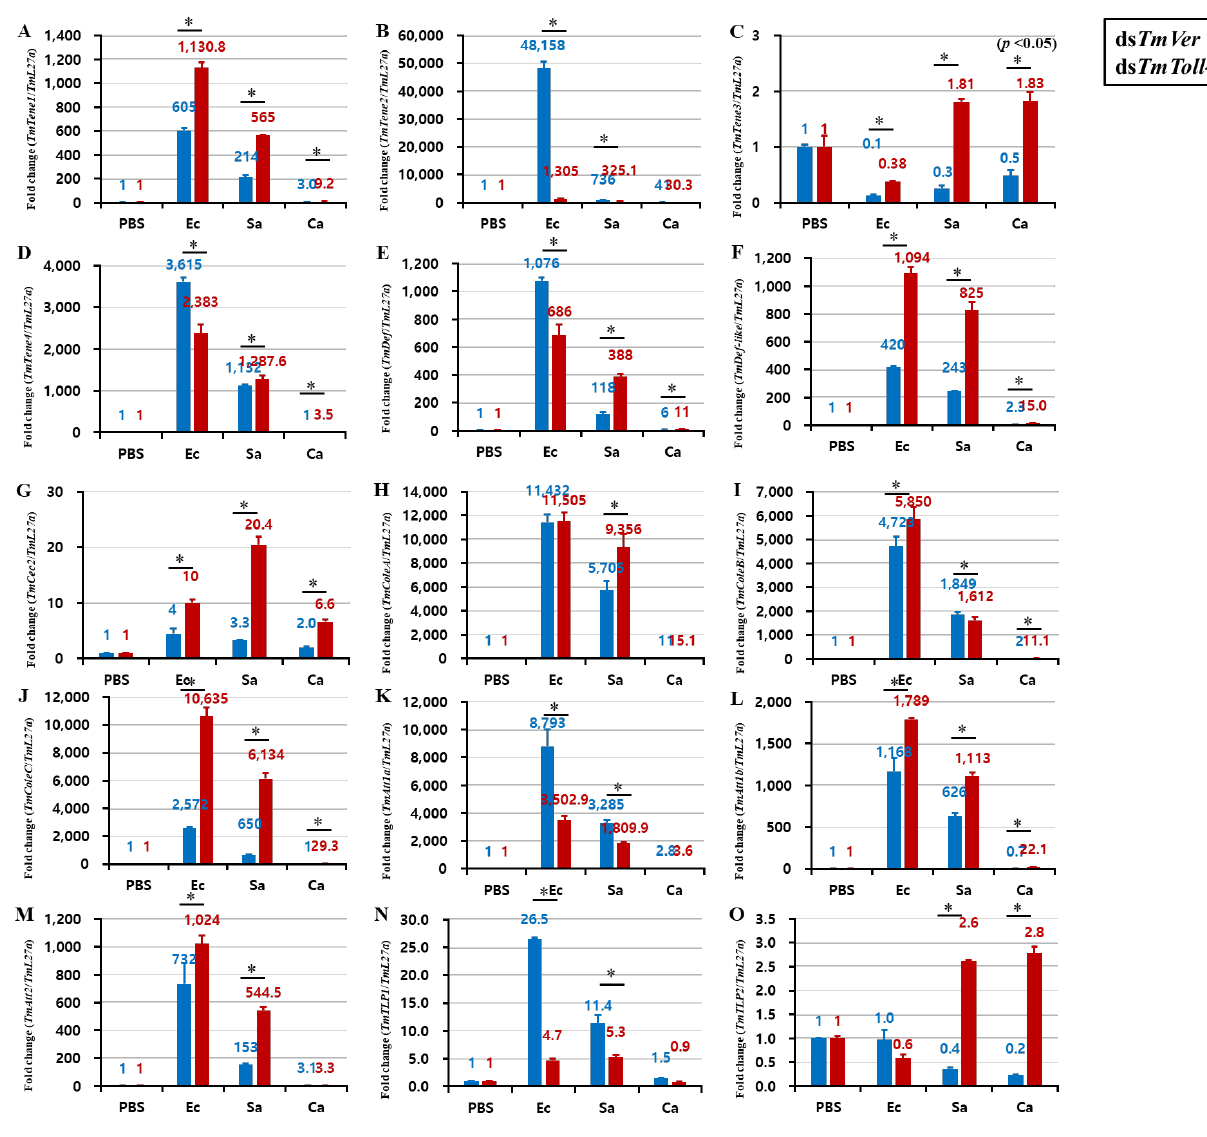
Figure 8. Induction of 15 AMP genes in the whole body of TmToll-2 -silenced T. molitor larvae infected with E. coli (Ec), S. aureus (Sa), and C. albicans (Ca) by using PBS as control. At 24 h post microbial injection, AMP genes, including TmTene1 ( A ), TmTene2 ( B ), TmTene3 ( C ), TmTene4 ( D ), TmDef ( E ), TmDef-like ( F ), TmCec2 ( G ), TmColeA ( H ), TmColeB ( I ), TmColeC ( J ), TmAtt1a ( K ), TmAtt1b ( L ), TmAtt2 ( M ), TmTLP1 ( N ), and TmTLP2 ( O ) were examined via qPCR by using ds TmVer as a knockdown control and T. molitor ribosomal protein ( TmL27a ) as an internal control. All experiments were performed in triplicate. Asterisks indicate significant differences between ds TmToll-2 - and ds TmVer RNAi-treated groups determined by Student’s t -test ( p < 0.05). In accordance with the same protocol used to evaluate the expression of AMP genes after TmToll-2 knockdown, we further examined the NF-kB pathway genes TmDorX1